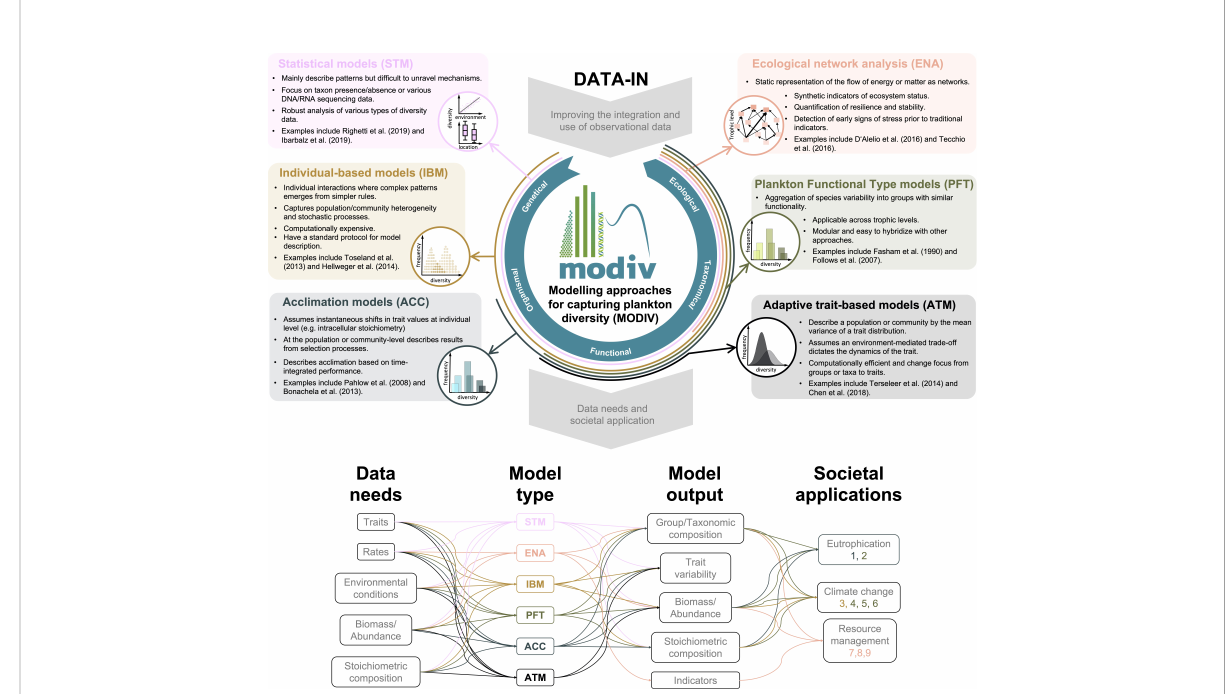
FIGURE 2 Key characteristics of six modelling approaches commonly used to capture various dimensions of plankton diversity. The inset of each model description depicts an idealized model output and where the term "diversity" represents a speci fi c measure of diversity for each dimension, i.e. Genetical, Organismal, Functional, Taxonomical, or Ecological. A better overview of model outputs is available through the examples mentioned for each method. In addition, we summarized main data requirements, outputs and common societal applications for each approach. Notice that some entries can both be data needs and model outputs. The latter is because variables in a modelling approach can be used to parametrize and/or validate a model but can also be a variable computed or predicted by the model. Code numbers: 1) Kerimoglu et al. (2018) (ACC), 2) Lancelot et al. (2007) (PFT), 3) Toseland et al. (2013) (IBM), 4) Kwiatkowski et al. (2018) (PFT), 5) Kwiatkowski et al. (2019) (PFT), 6) Henson et al. (2021) (PFT), 7) de la Vega et al. (2018) (ENA), 8) Meddeb et al. (2018) (ENA), 9) Saint-Be ́ at et al. (2020)